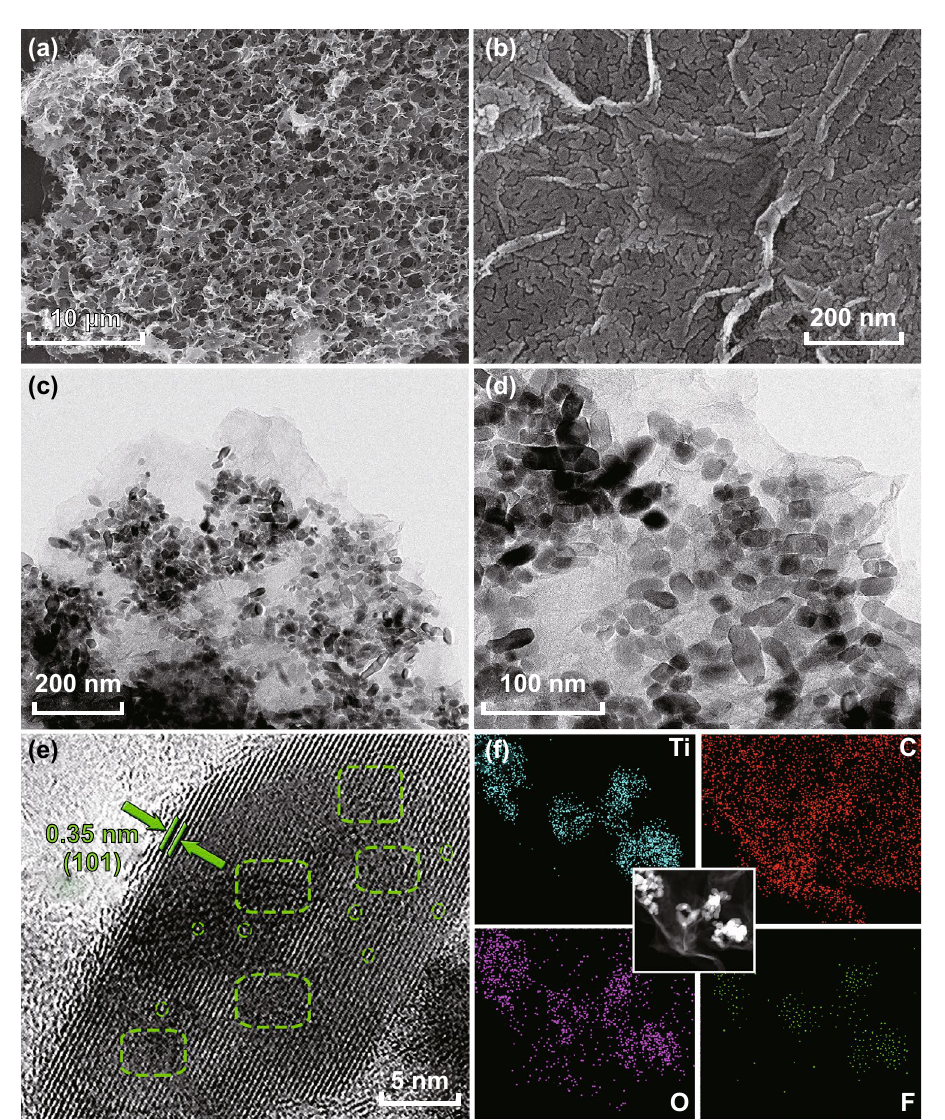
Fig. 2 Microscopic morphology of M‑TiO 2 @rGO foam. a , b SEM images; c , d TEM images; e HR‑TEM image; and f dark field TEM and EDS mapping of C, O, Ti, and